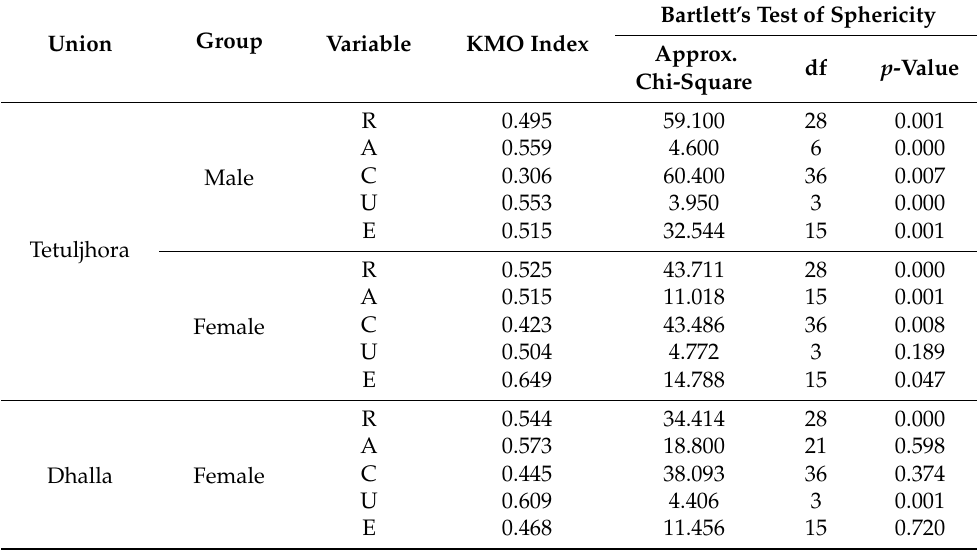
Table 2. Factorability tests (KMO and Bartlett’s tests) for industrial workers in peri-urban areas around